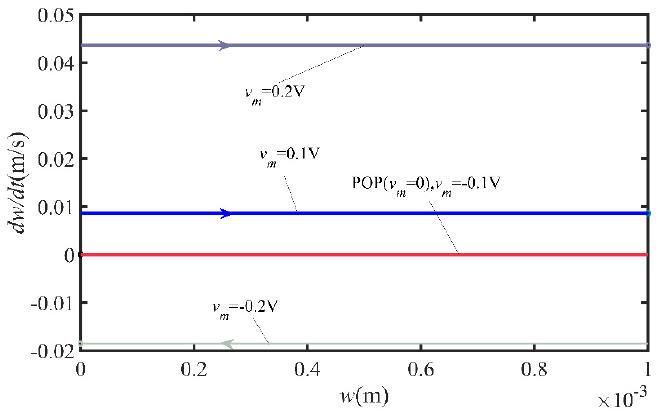
Figure 9. Dynamic routes of the Self-Directed Channel (SDC) memristor. Tote that POP ( v m = 0) and the line corresponding to v m = 0.1 V are in fact two different lines.